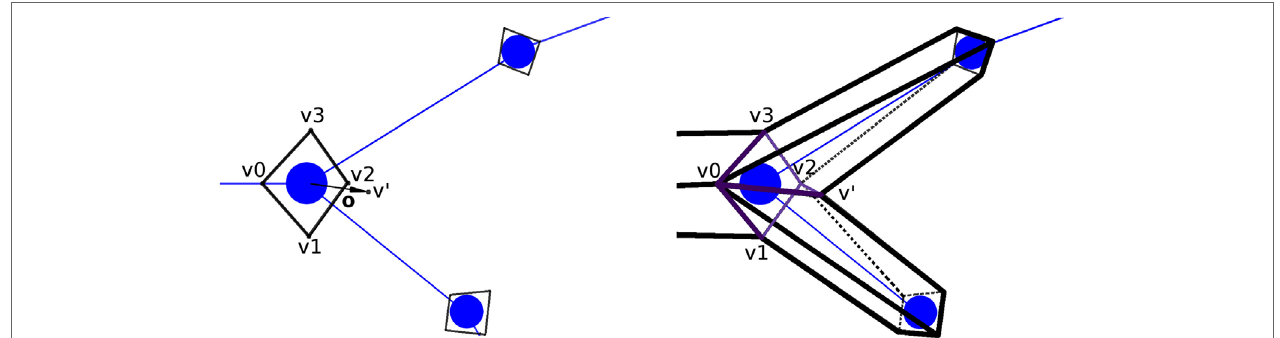
FIGURe 5 | Generation of the extra vertex, v ′ , at bifurcation tracing points, at a distance equal to the radius of the bifurcation (left image), for its posterior stitching (right image). In this example, the new quads (separated by the bifurcation section-quad diagonal v0–v2) are [v0,v1,v2,v ′ ] and [v0,v ′